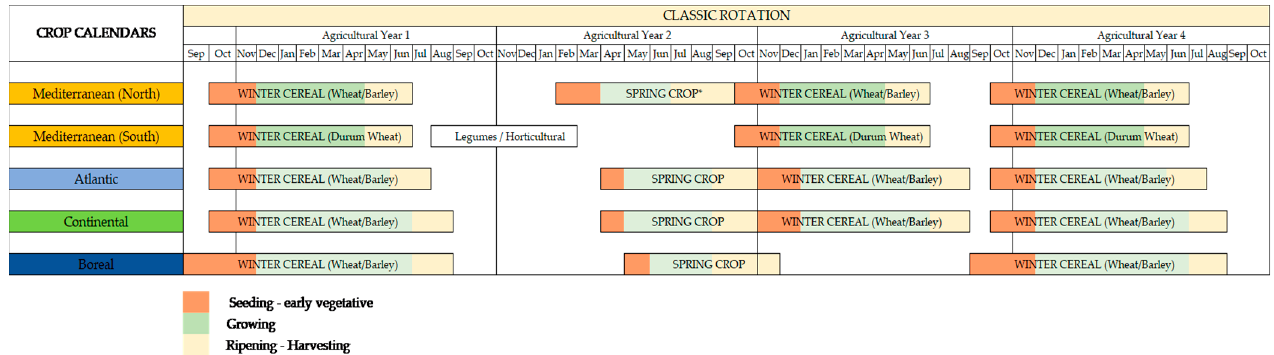
Figure 2. Classic calendar crop (Agri4Cast data). The periods in which each crop is cultivated is differentiated with the three colors. Table 2. Sequential crop